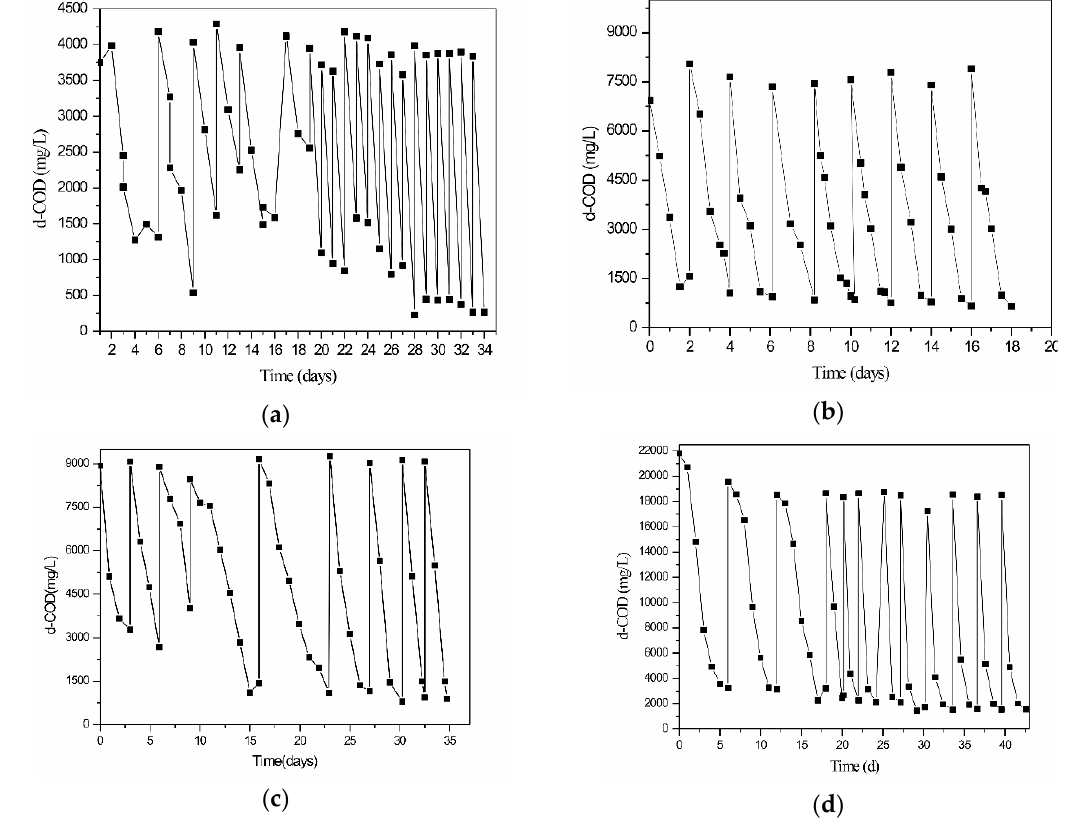
Figure 2. Operating cycles of the trickling filter under batch operating mode with a recirculation rate of 0.5 L / min for initial dissolved chemical oxygen demand (d-COD) concentration of: ( a ) 3500 mg / L ( b ) 7500 mg / L ( c ) 9000 mg / L and ( d ) 18,000 mg / L. Recorded duration of minimum stable cycles: ( a ) 24 h, ( b ) 48 h, ( c ) 54 h, and ( d ) 64 h.